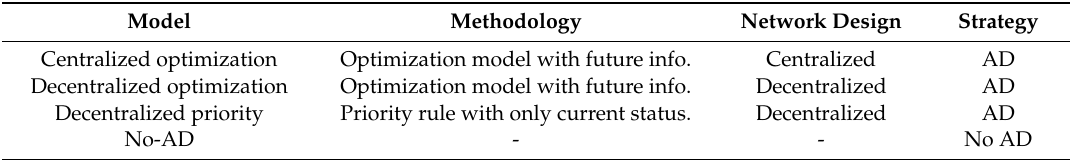
Table 1. Classification of ambulance diversion (AD) decision-making